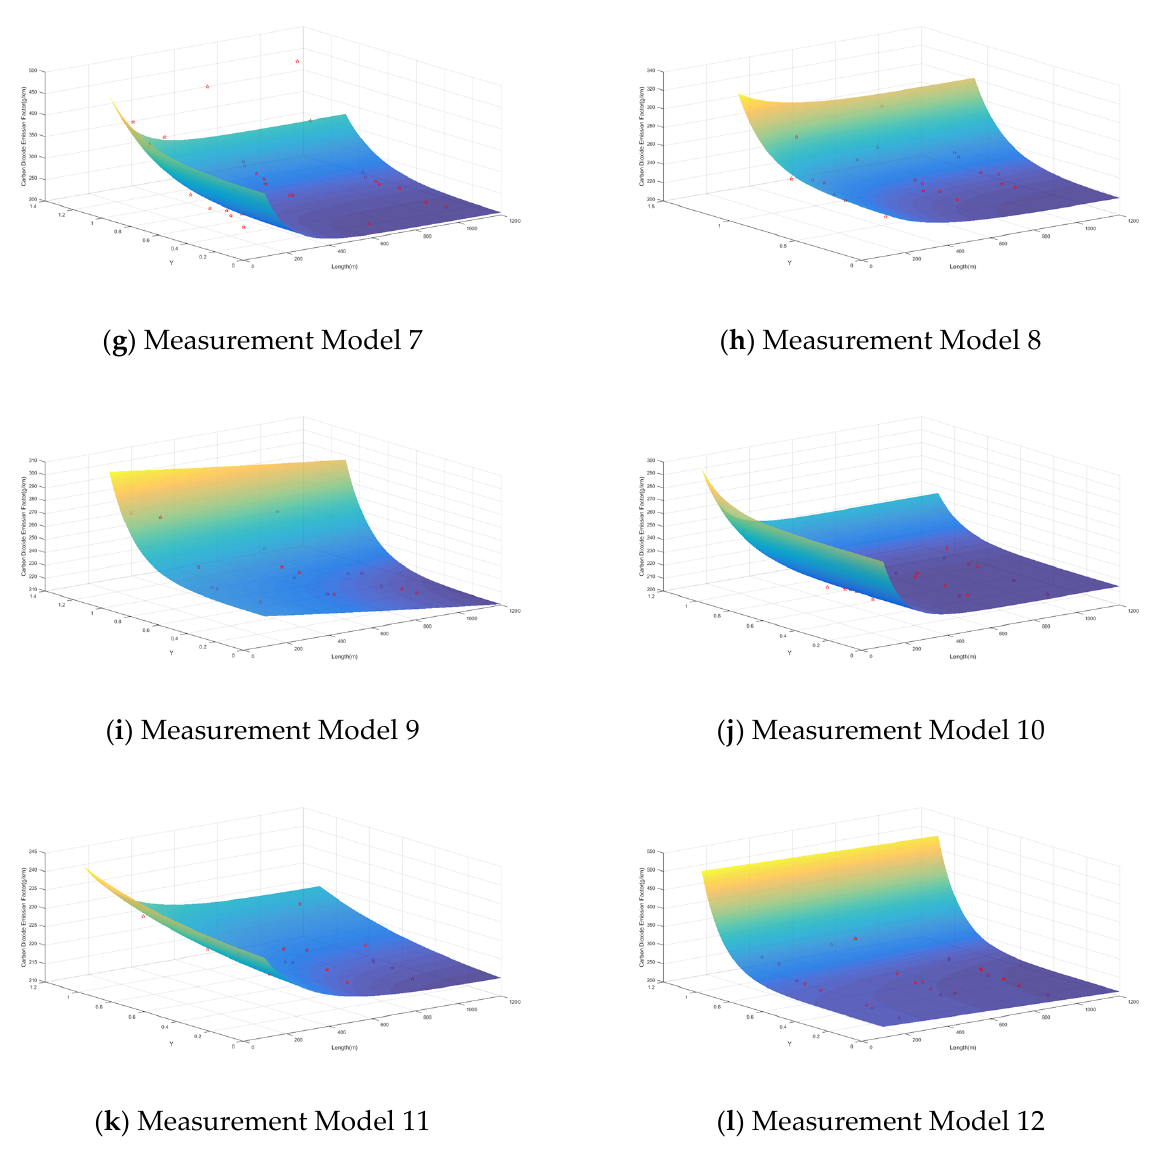
Figure 7. Graphics for the twelve measurement models and data used for model calibration. ( a ): Measurement Model 1, ( b ): Measurement Model 2, ( c ): Measurement Model 3, ( d ): Measurement Model 4, ( e ): Measurement Model 5, ( f ): Mea- surement Model 6, ( g ): Measurement Model 7, ( h ): Measurement Model 8, ( i ): Measurement Model 9, ( j ): Measurement Model 10, ( k ): Measurement Model 11, ( l ): Measurement Model